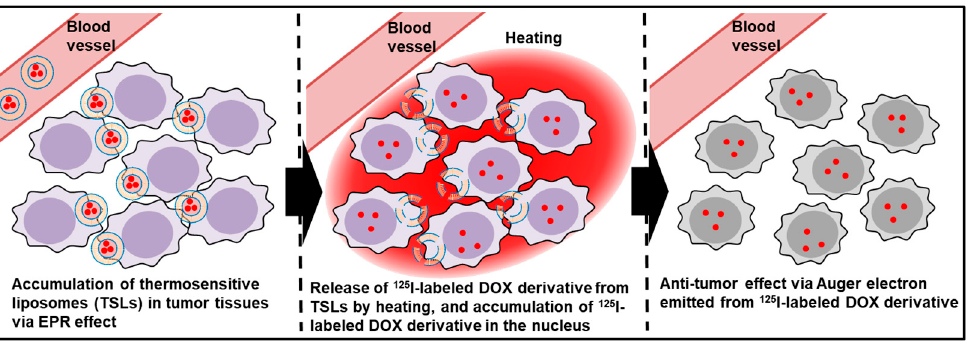
Figure 1. A schematic diagram. Strategy for Auger electron therapy using TSLs and hyperthermia.